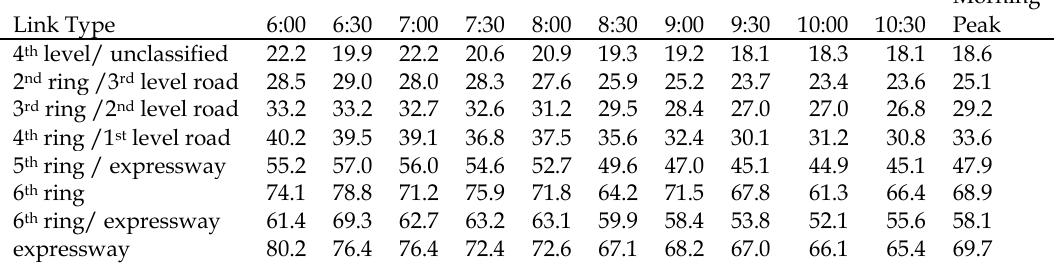
Table 5. Average congested link speed (kph) by link type in each time